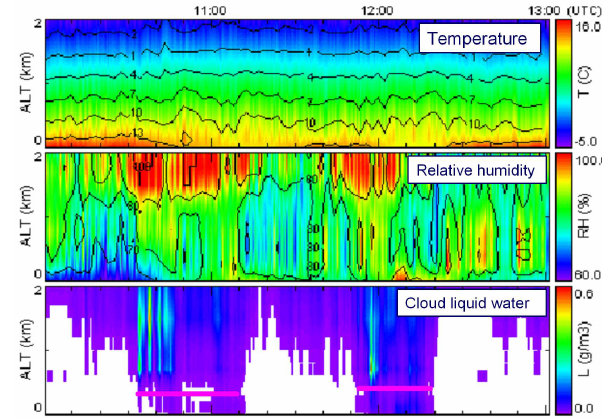
Fig. 10c. Microwave radiometer retrieval showing temperature, rel- ative humidity and liquid water time-height cross sections for 0– 2km height, 25 August 2005, 10:00–13:00UTC.